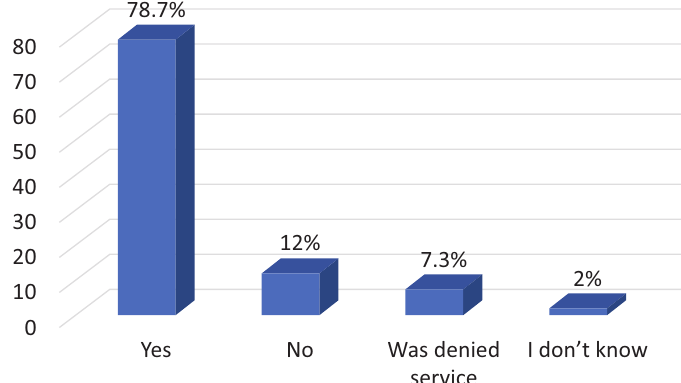
Figure 1. Parents of children with disabilities who experienced severely hampered access to social services during the pan‐ demic (N =